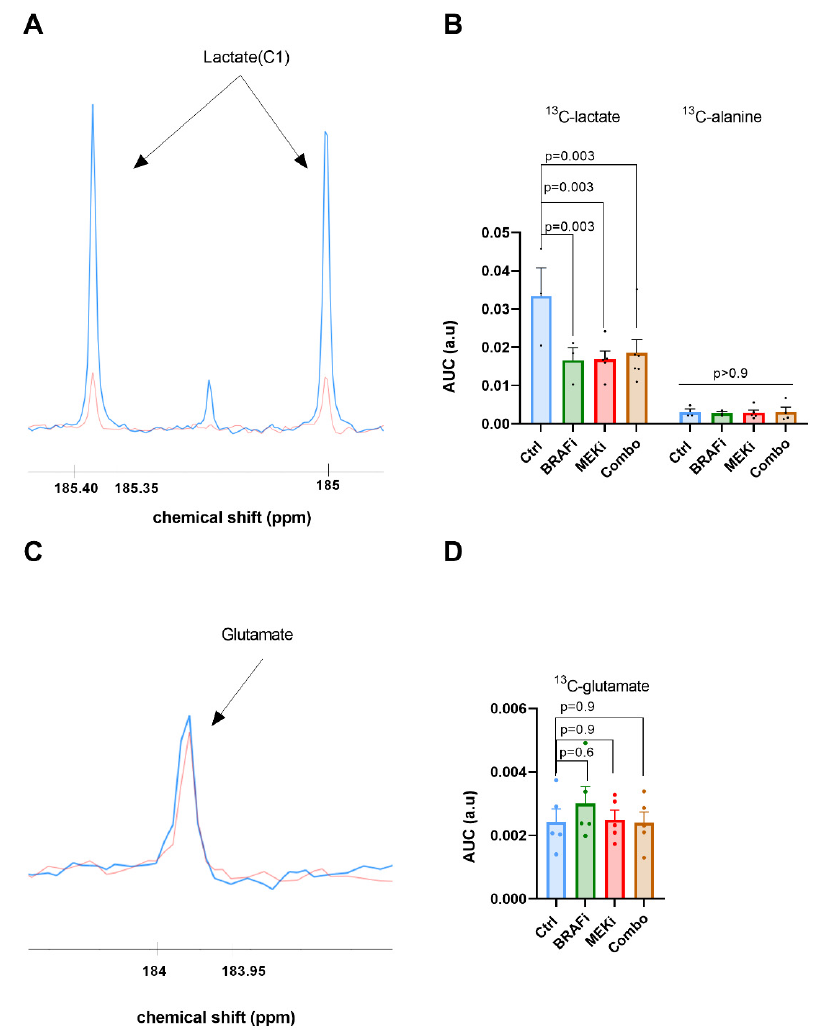
Figure 3. Ex vivo 13 C metabolic profiling after 13 C glucose or 13 C glutamine feeding (fluxomic experiments) in response to BRAF and/or MEK inhibition. Representative spectra of lactate C1 issued from the 13 C glucose metabolism in the control group (blue) and in the BRAFi/MEKi treated group (orange) ( A ). Quantification of the 13 C detectable metabolites in YUMM1.7 xenografts, represented by the area under the curve corrected for internal standard (TSP) and tumor mass, arbitrary units (a.u.), two-way anova, Holm-Sidak multiple comparisons test. Sample size n = 3 for Ctrl and BRAF i and n = 5 for MEK i and BRAFi/MEK i (Combo) ( B ). Representative spectra of glutamate issued from the 13 C glutamine metabolism in the control group (blue) and in the BRAFi/MEKi treated group (orange) ( C ), and 13 C glutamate quantification (a.u.), one-way anova, Holm-Sidak multiple comparisons test n = 5/grp ( D